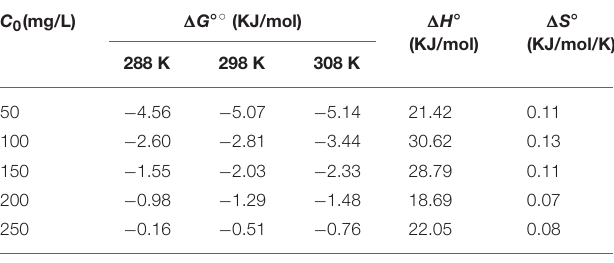
TABLE 5 | Thermodynamic parameters of iodine adsorption over JLUE-COP-3. C 0